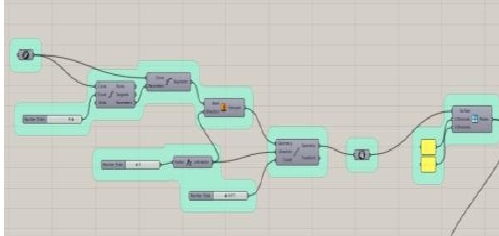
Figure 19. Alternative 1 script. Grasshopper script.